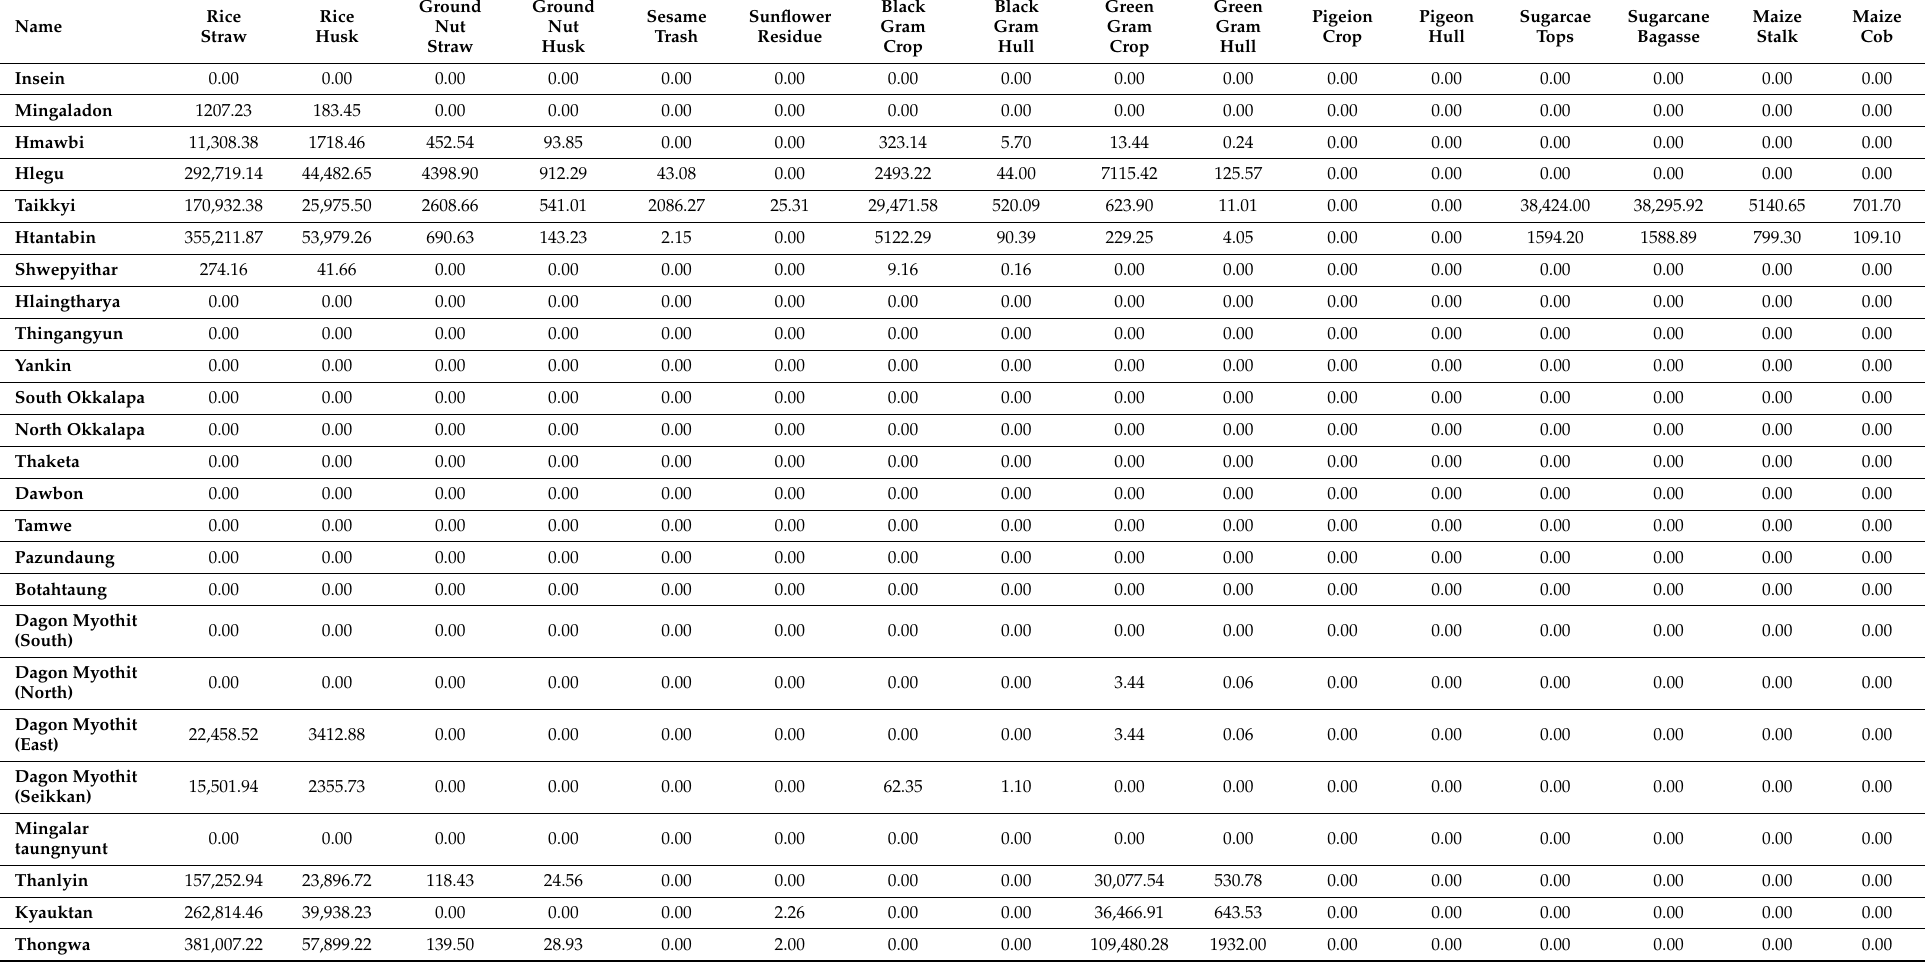
Table A6. Crop Residue feedstock (ton/year) in Yangon Region